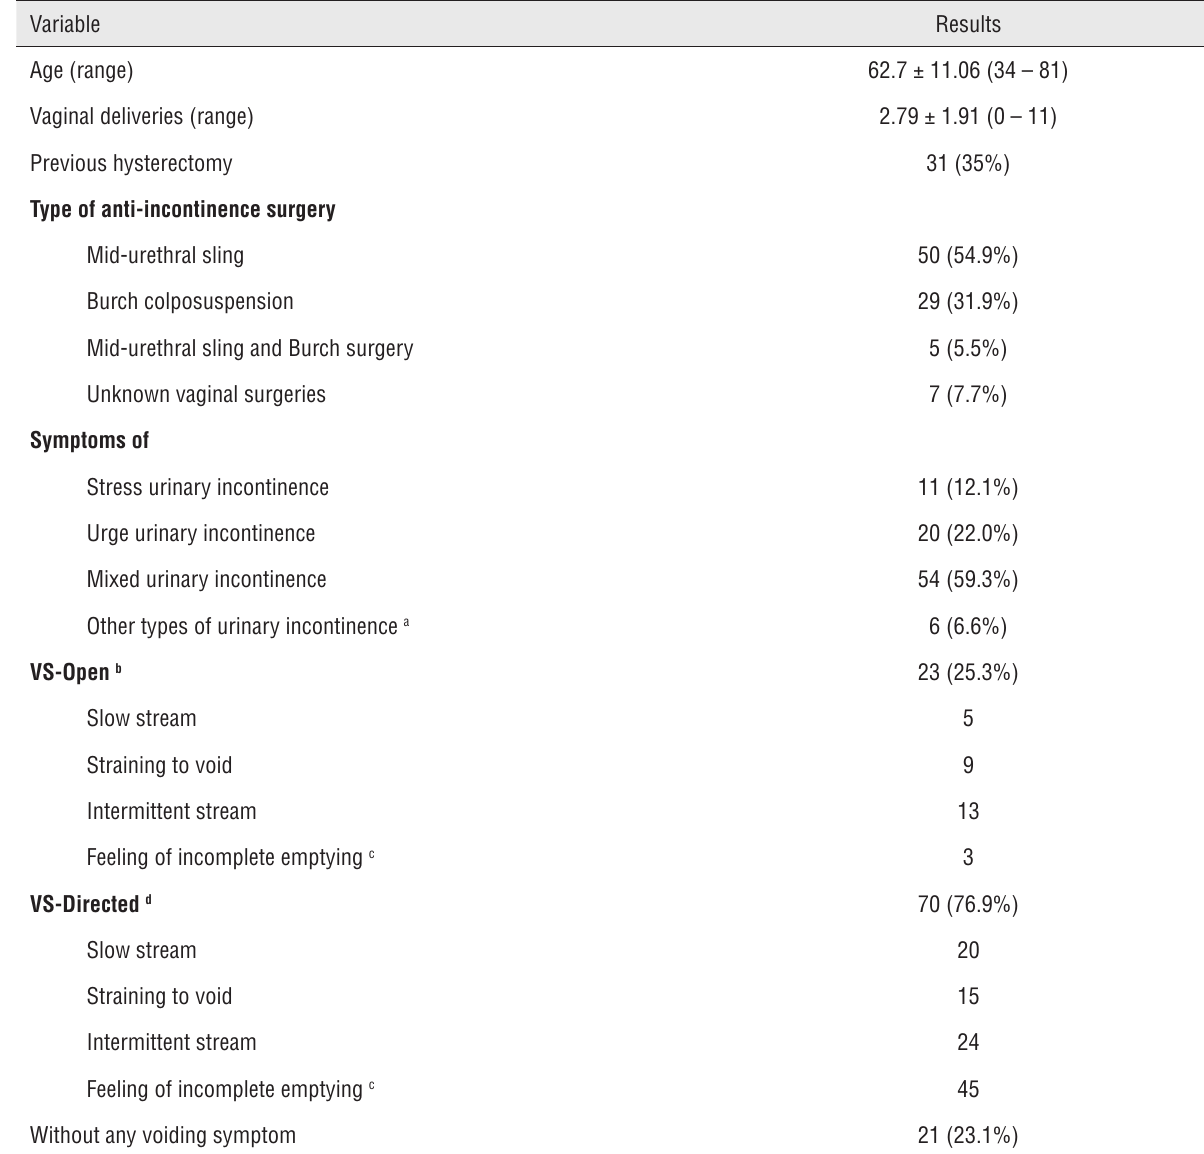
Table 1 - Medical history in women with previous anti-incontinence surgery undergoing urodynamics (n = 91). Variable